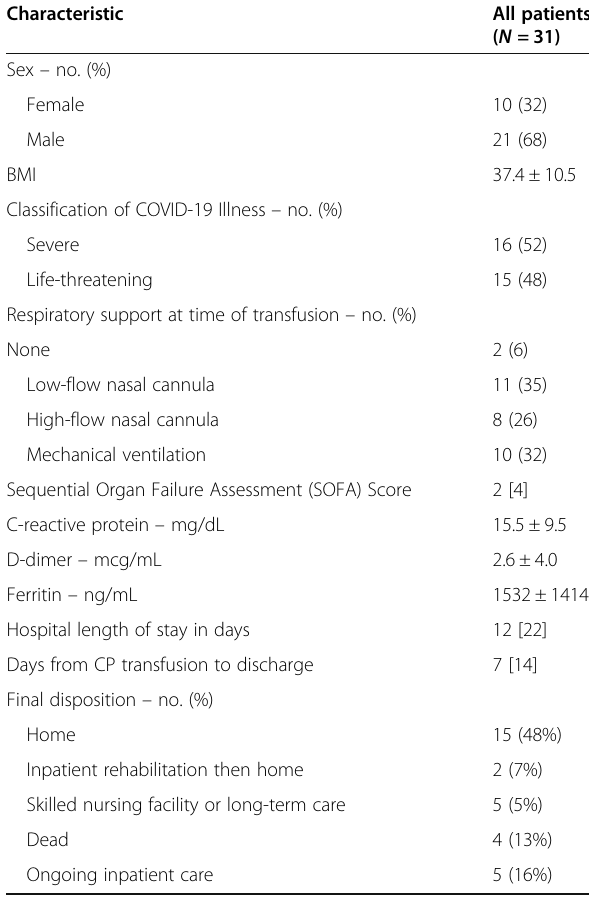
Table 1 Characteristics of patients receiving COVID-19 convalescent plasma at time of transfusion a